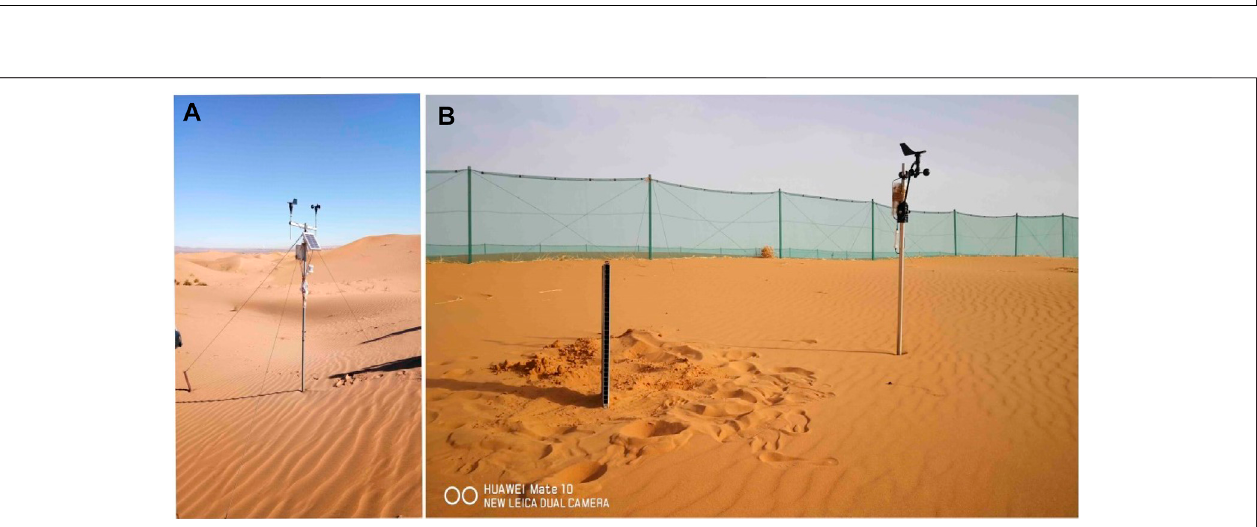
FIGURE3| Observation instruments on theTenggerDesert section ofthe Wuhai – Maqin Highway: (A) HOBO-U30automatic meteorologicalstation, and (B) sand trap and HOBO-U21 automatic meteorological station.